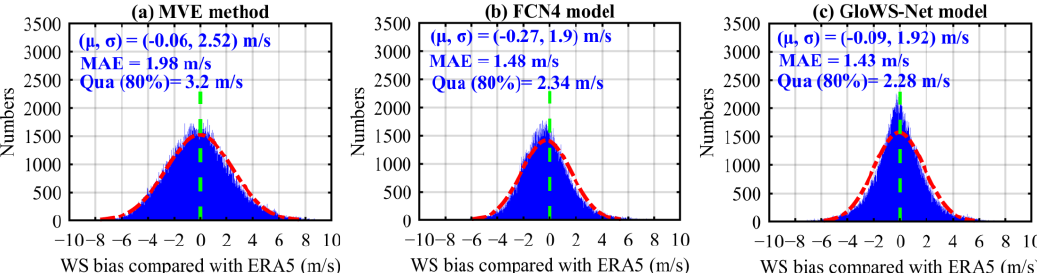
Figure 8. Deviation distribution histograms between ERA5 wind speed and retrieved wind speed by different models.